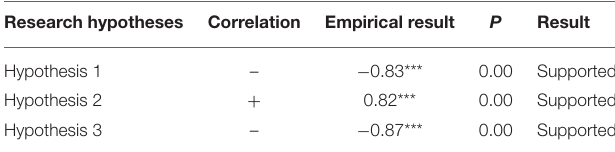
TABLE 4 | Hypotheses